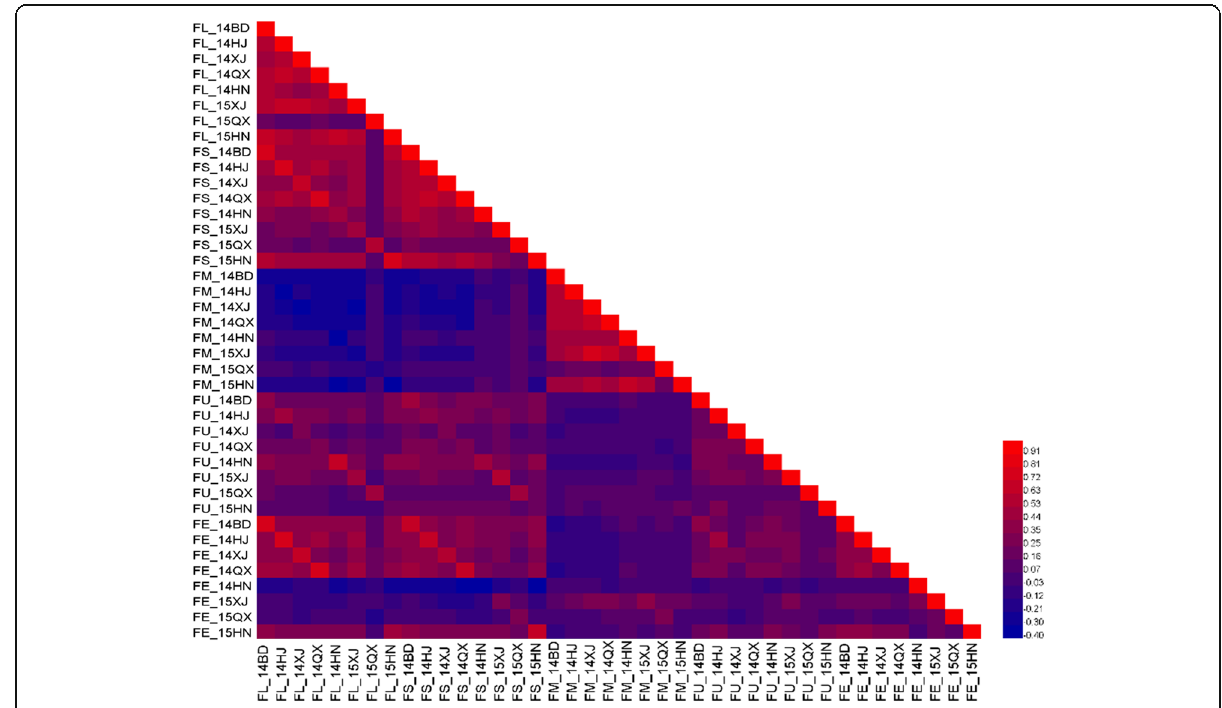
Fig. 2 Correlation coefficients among the 40 phenotypic traits using 719 upland cotton genotypes evaluated in 2014 and